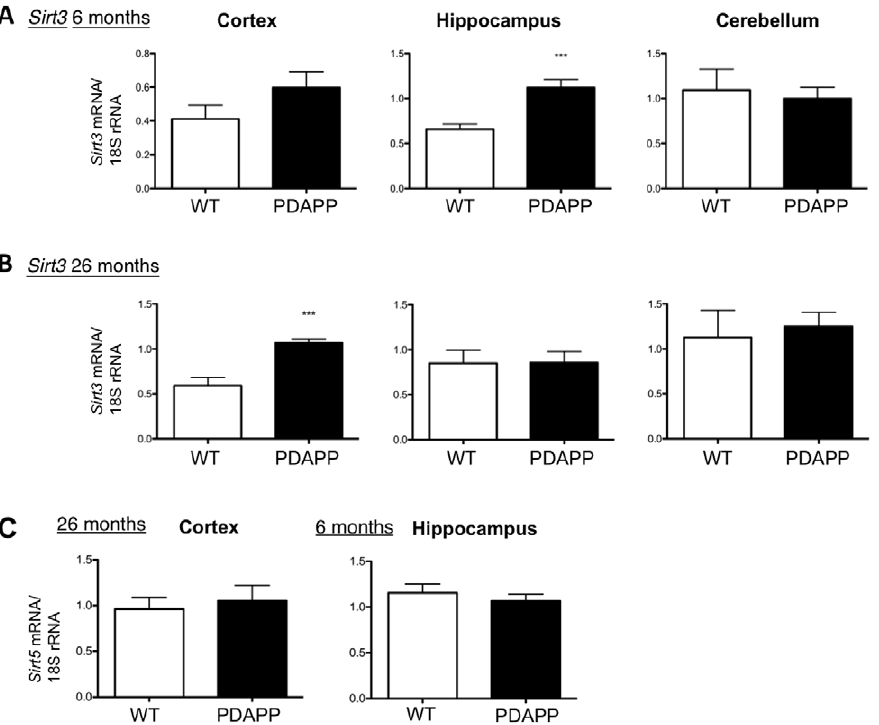
Figure 3. Sirt3 mRNA is upregulated in a specific spatio-temporal pattern in a mouse model of AD. A. Sirt3 mRNA expression is significantly upregulated in hippocampus samples of 6 months-old PDAPP mice (n=9 2 10, ***P , 0.001) with no alteration in cortex (n=10) and cerebellum (n=10). Sirt3 mRNA was measured and normalized to 18S rRNA using TaqMan multiplex QPCR. B. Sirt3 mRNA expression is significantly upregulated in cortex samples of 26 months-old PDAPP mice (n=6 2 7, ***P , 0.001) with no alteration in hippocampus (n=8) and cerebellum (n=6 2 7). C. Sirt5 mRNA is unaltered in 6 months-old hippocampus and 26 months-old cortex PDAPP samples.